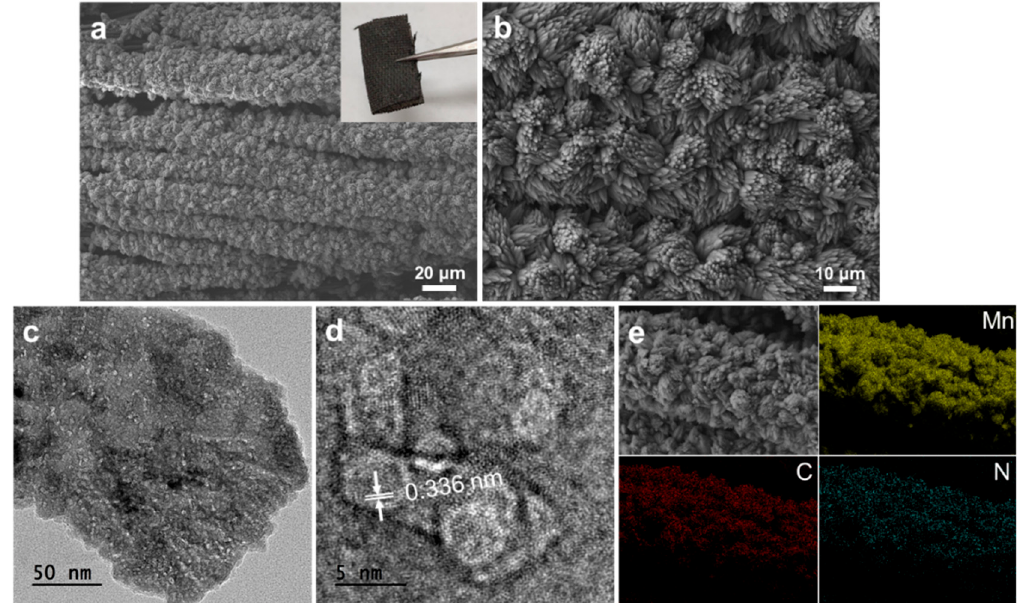
Figure 2. ( a , b ) SEM images of g-C 3 N 4 quantum dots/MnCO 3 on carbon cloth (q-MC//CC). ( c ) TEM image of q-MC//CC and ( d ) High resolution TEM (HRTEM) image. ( e ) Energy-dispersive X-ray spectroscopy (EDS) mapping images of q-MC//CC.